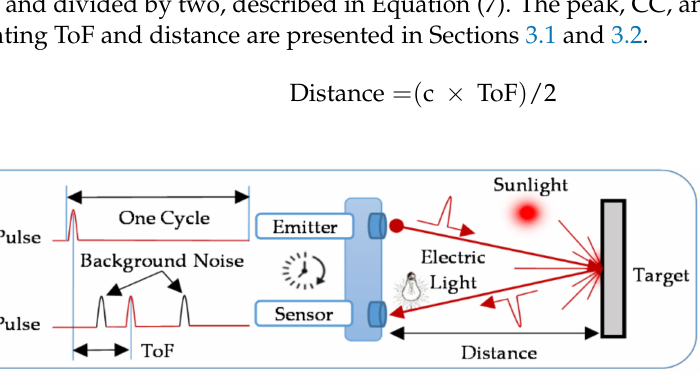
Figure 6. Principle of estimating ToF and